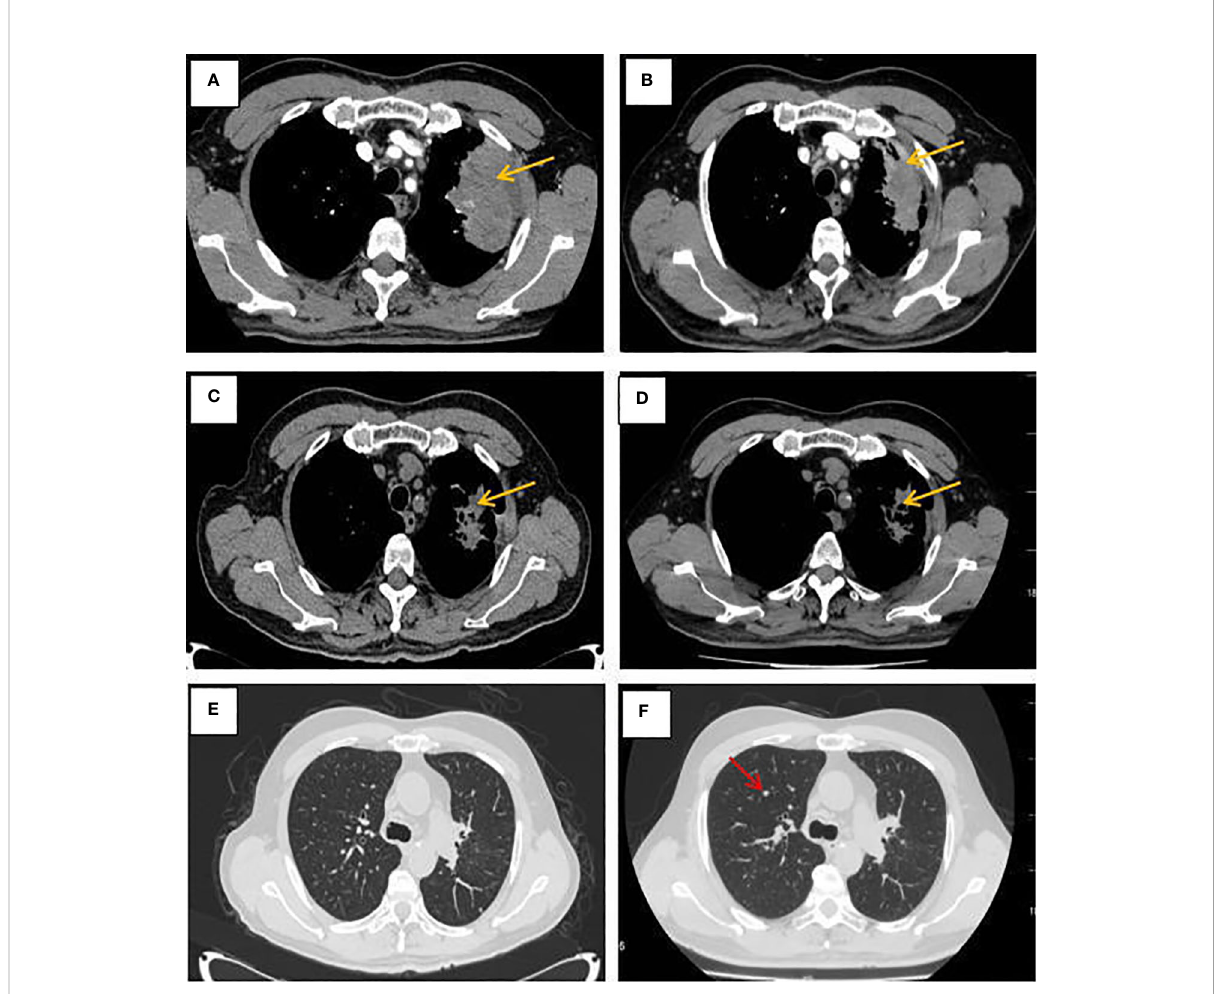
FIGURE 1 CT of the lungs at different times. (A – D) Mediastinal Window; (E – F) window of lung fi elds. (A) Pulmonary lesion before treatment. (B) CT revealed a stable disease after 2 cycles of albumin-bound paclitaxel and cisplatin in combination with sintilimab. (C) CT revealed a stable disease after 6 cycles of albumin-bound paclitaxel and cisplatin in combination with sintilimab. (D) CT showed no signi fi cant changes in the primary lesion of the left lung after sequential 2 cycles of sintilimab immune monotherapy maintenance treatment. (E) The window of lung fi elds after 6 cycles of albumin-bound paclitaxel and cisplatin in combination with sintilimab. (F) CT revealed pulmonary metastases increased after sequential 2 cycles of sintilimab immune monotherapy maintenance treatment (as the red